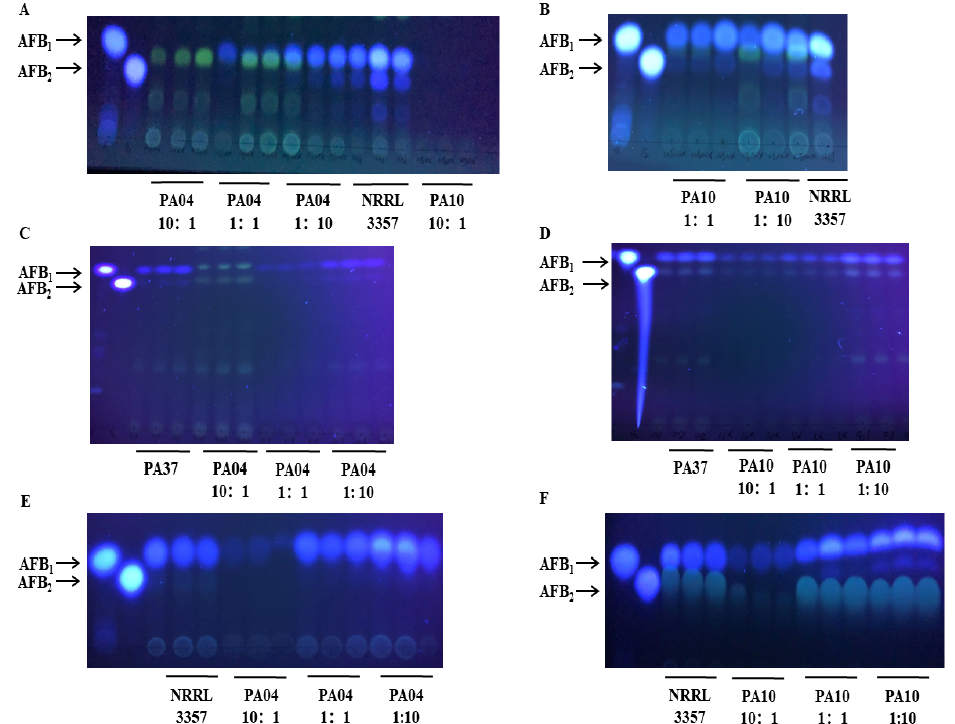
Figure 3. Thin layer chromatographs visualized under 365 λ UV light for aflatoxin extracts from co-inoculation experiments. Aflatoxin producer NRRL3357 alone and co-inoculated with three concentrations of either PA10 or PA04 and incubated at 30 ◦ C for seven days on peanut ( A , B ) and 10 d on PDA medium ( E , F ). Aflatoxin producer PA37 alone and co-inoculated with three concentrations of either PA10 or PA04 and incubated at 30 ◦ C for seven days on peanut ( C , D ).